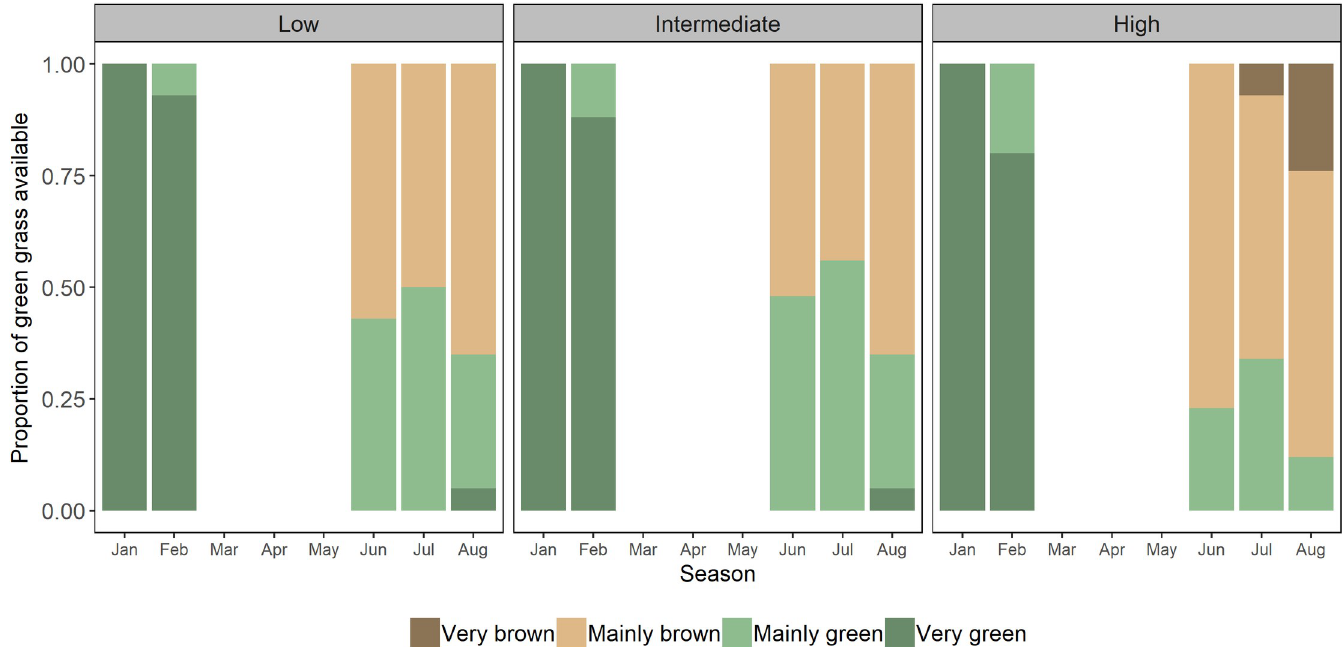
Fig 2. Availability of green grass. Seasonal differences in the availability of green grass in the different grass greenness categories for low, intermediate, and high cattle stocking rates (low: 1.7 ha per animal unit (AU); intermediate: 1.5 ha per AU; high: 0.95 ha per AU). Greenness categories are very brown 0–10%, mainly brown 11– 50%, mainly green 51–90%, and very green